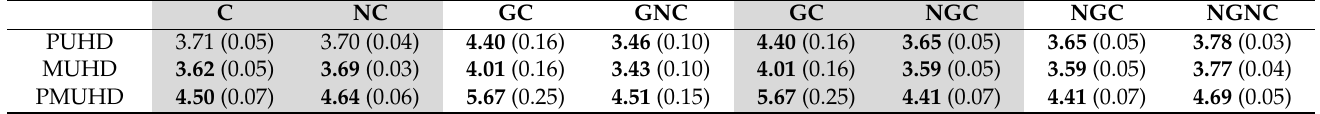
Table 3. Overall (average over all years) numbers of unhealthy days. (See table notes for explanation).